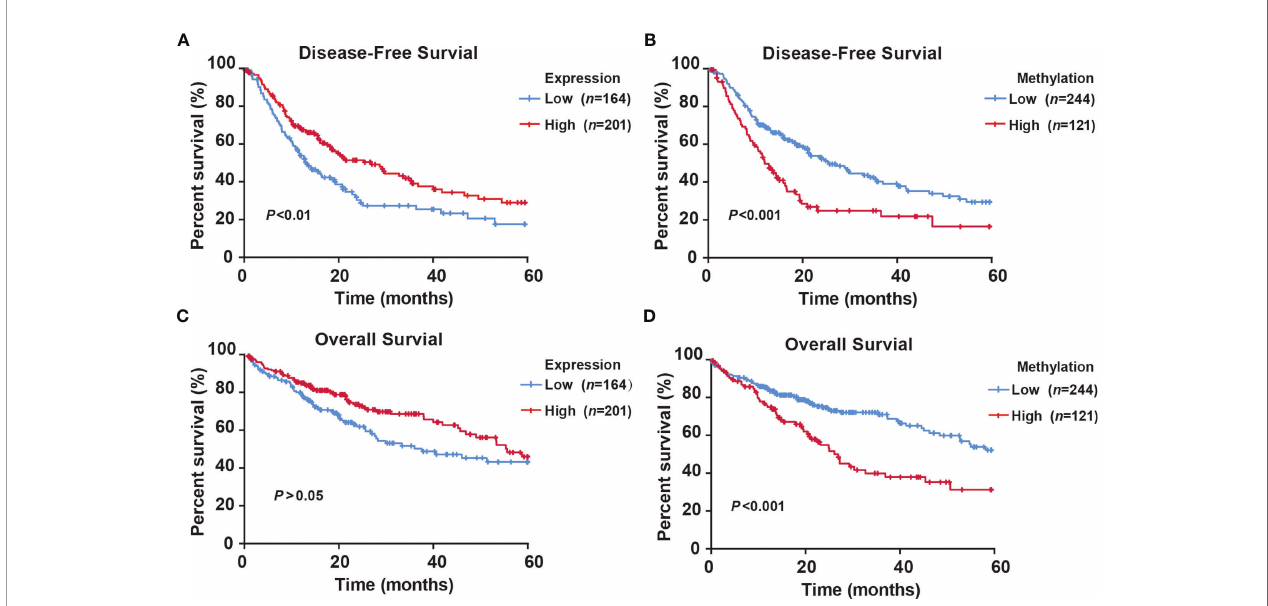
FIGURE 6 | Kaplan – Meier survival curve comparing high and low levels of RNF135 expression or methylation in HCC patients from the TCGA. (A) The disease-free survival curve for HCC patients with high or low expression level of RNF135. (B) The disease-free survival curve for HCC patients with high or low methylation level of RNF135. (C) The overall survival curve for HCC patients with high or low expression level of RNF135. (D) The overall survival curve for HCC patients with high or low methylation level of RNF135.